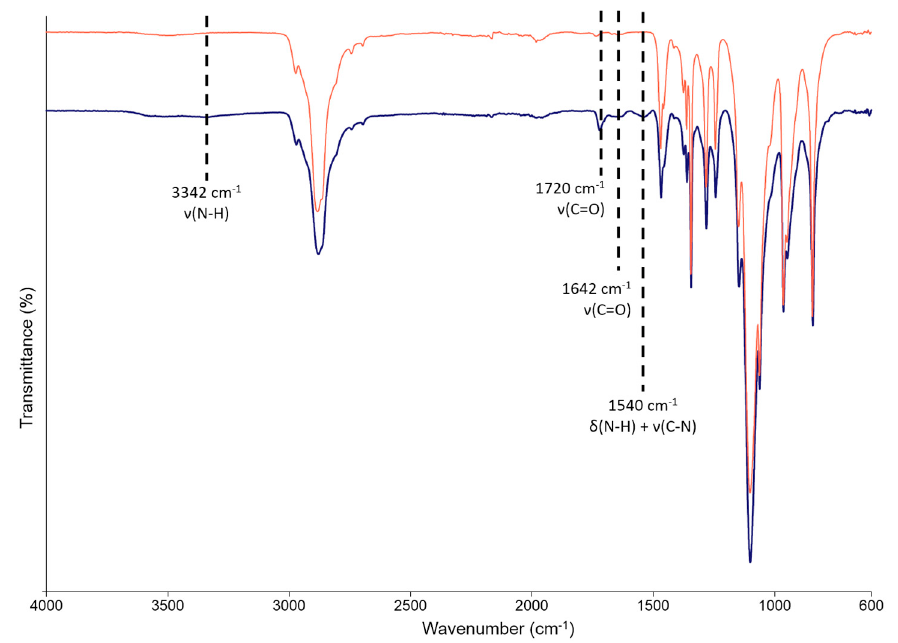
Figure 4. Attenuated total reflectance Fourier transformed infrared (ATR-FTIR) spectra of P407 (red) and CHP407 (blue). Dashed lines identify the characteristic signals of newly formed urethane bonds in CHP407.